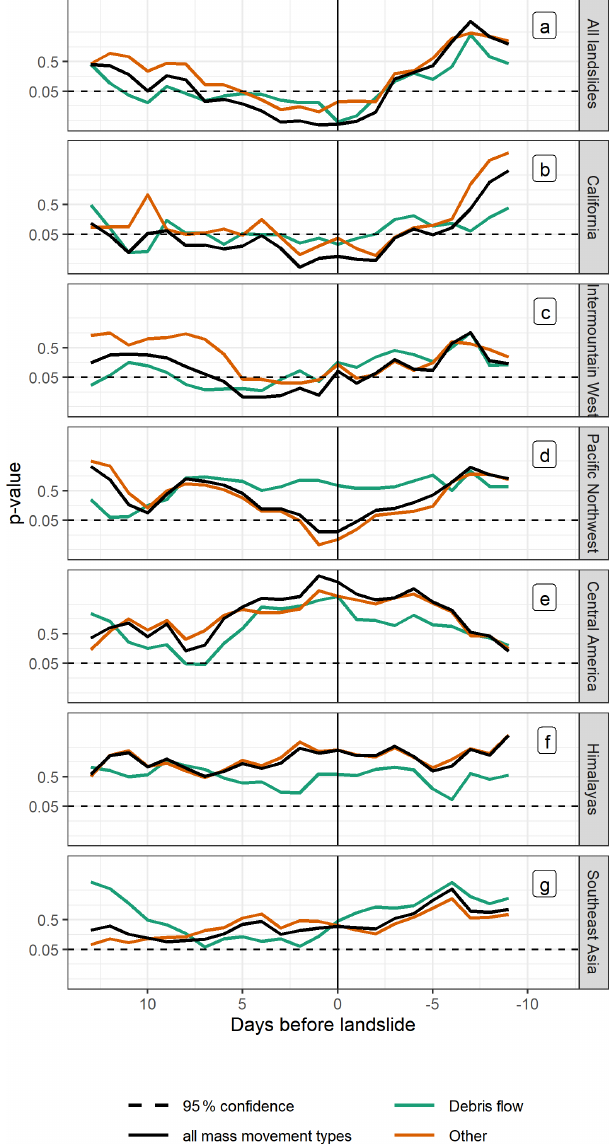
Figure 5. p values of Mann–Whitney tests comparing mass- movement-triggering precipitation percentiles at burned and un- burned sites. The black line shows results for all mass movements, while debris flows and other mass movements are shown in green and orange, respectively. A horizontal dashed black line shows a 95% confidence level for the hypothesis test, and a vertical black line indicates the day of the mass